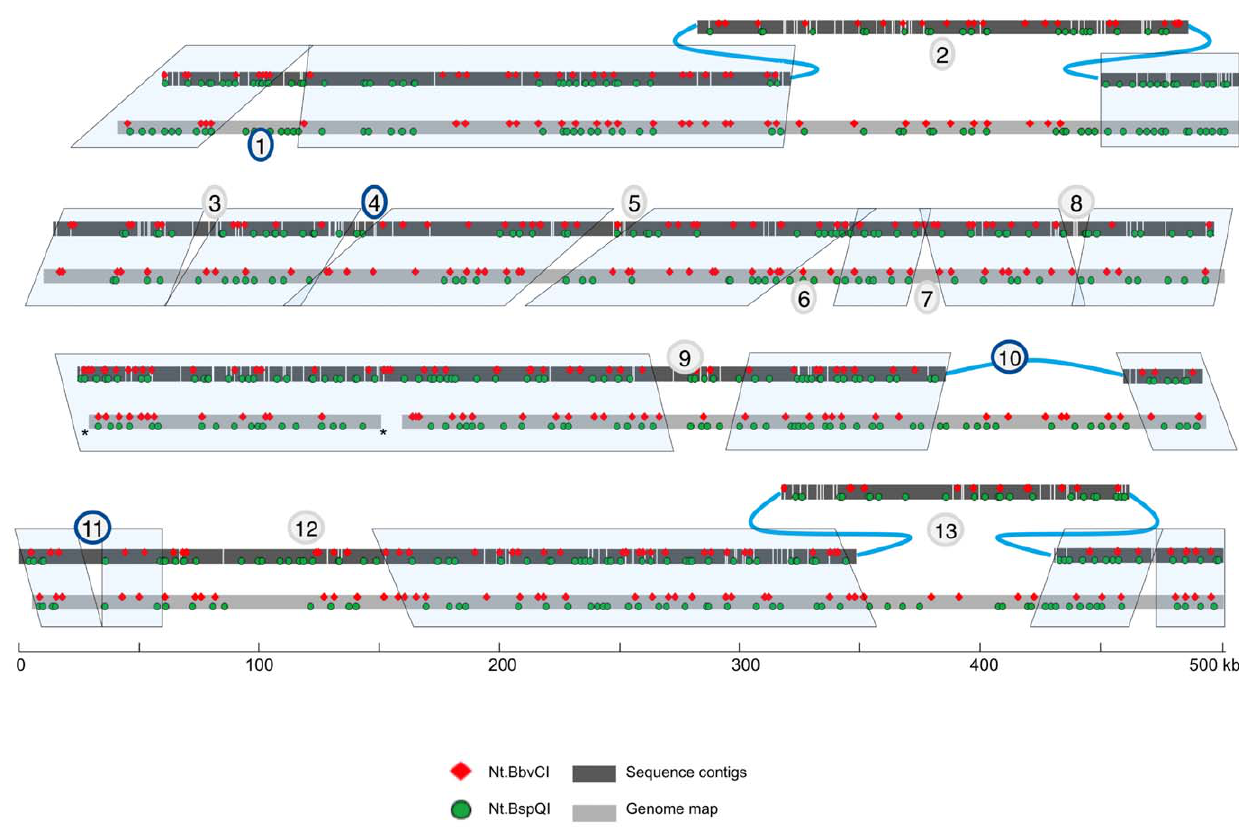
Figure 2. Comparison of the sequence assembly scaffold to the genome map. The sequence assembly is shown with dark grey boxes representing sequence contigs. Contigs were bridged by paired-end sequence reads. The genome map is represented by light grey boxes. Shaded boxes around regions of both maps denote regions where the sequence assembly matches the genome map well. Regions where there are significant discrepancies are numbered and discussed in the results section. The two gaps in the genome map are denoted with asterisks.